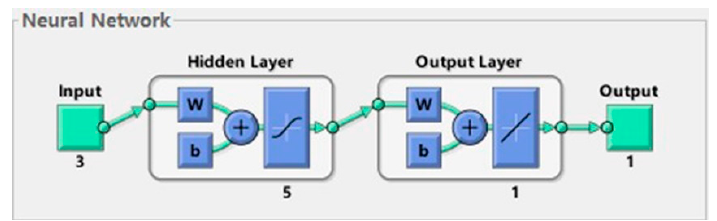
Table 4. Training accuracy under different numbers of hidden layer neurons.